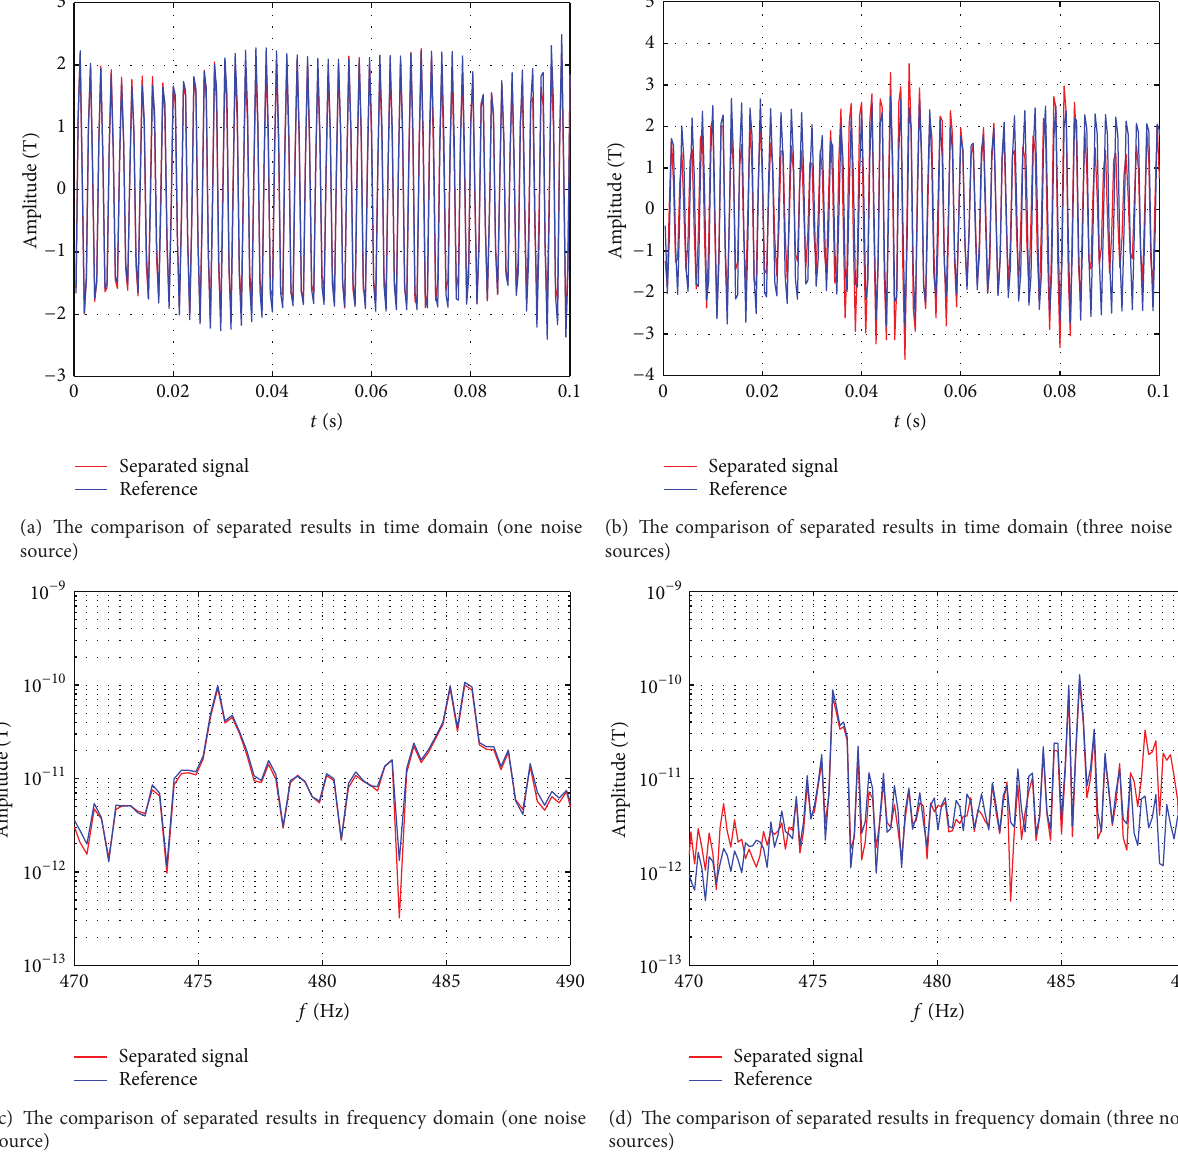
Figure 6: The separated results.